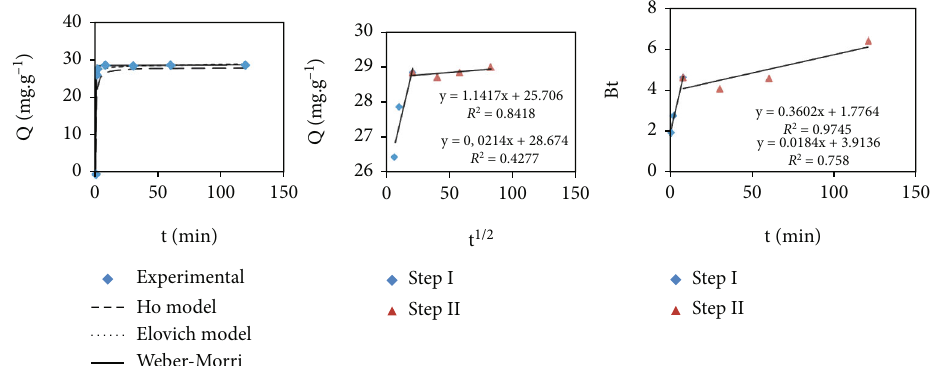
Figure 5: Experimental curves and the Ho, Elovich, and Webber-Morri models of the kinetic study of Cu(II) ion adsorption in sodium